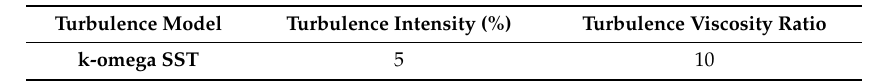
Table 4. Turbulence modelling set-up.